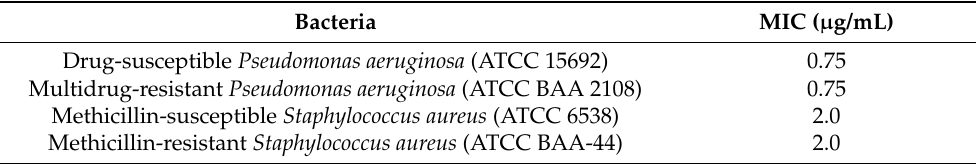
Table 1. MIC values of (BiO) 2 CO 3 NPs against four different strains of bacteria.